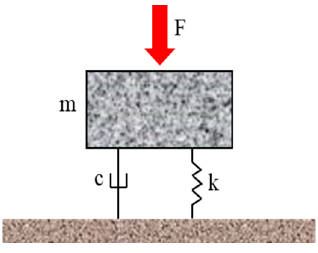
Figure 2. Single degree of freedom scheme.